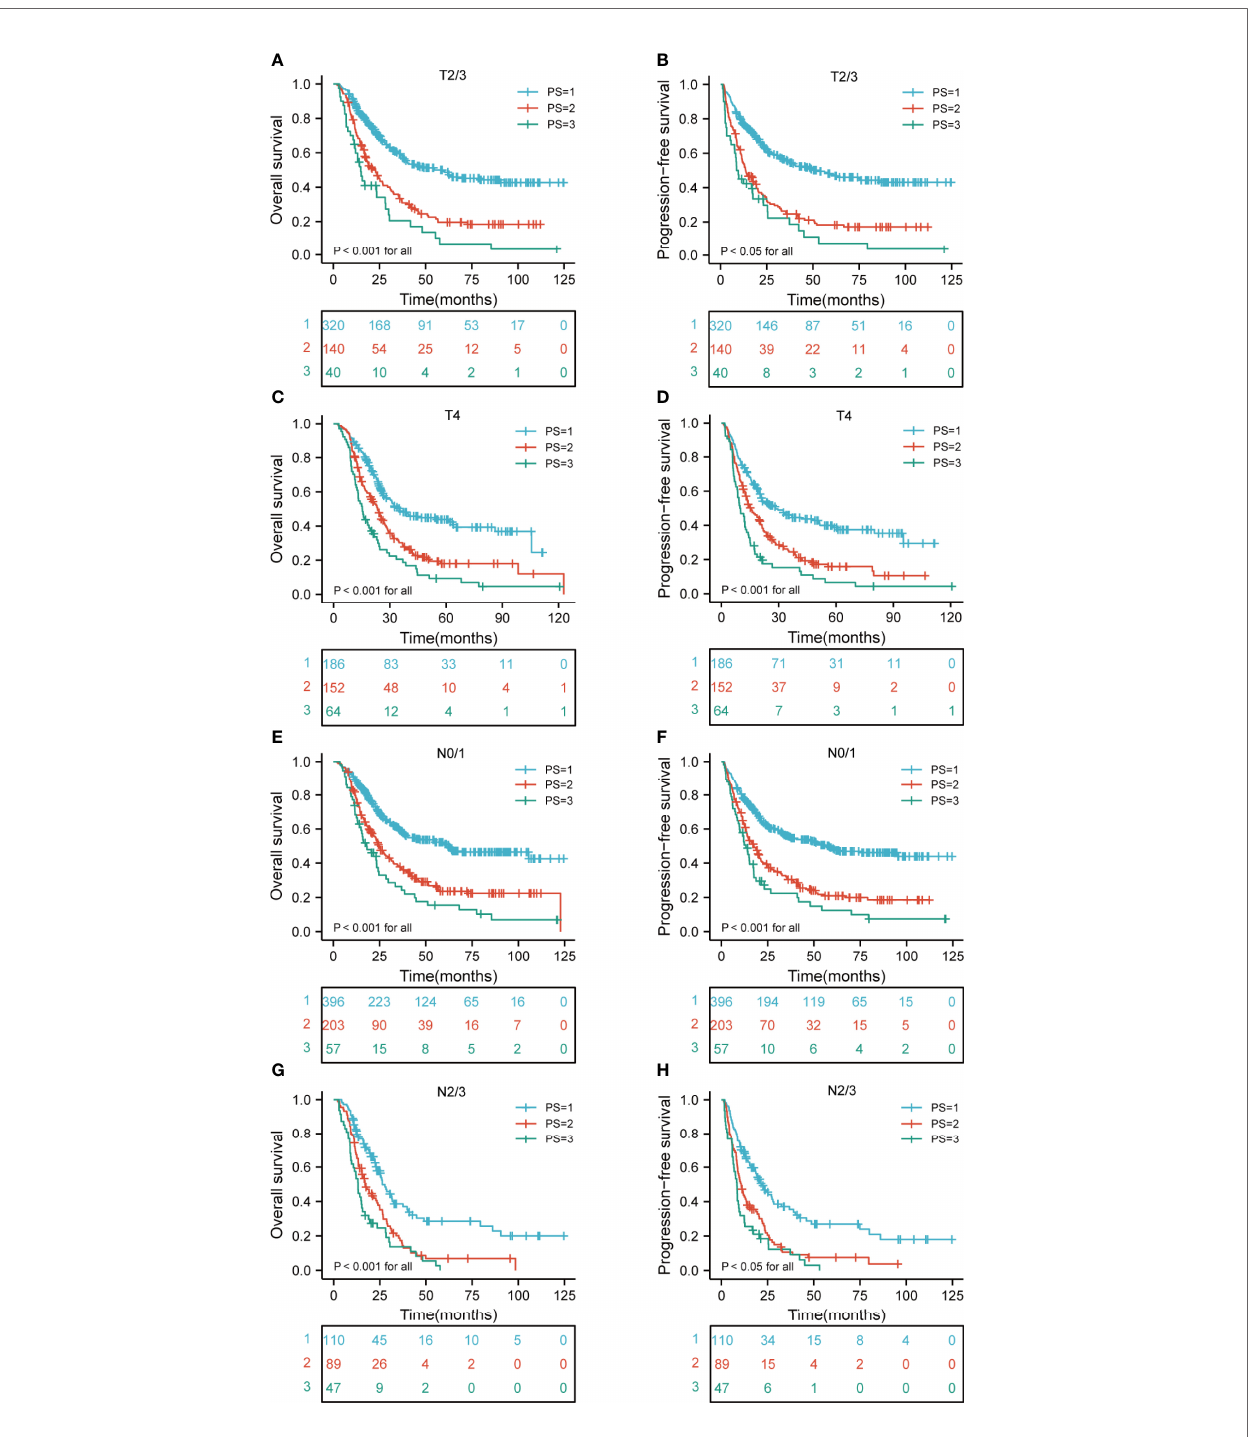
FIGURE 4 | Kaplan-Meier curves according to T and N stage categories for the whole study population according to risk groups showing (A – D) OS and PFS (p < 0.05 for all) of patients with T2-4; (E – H) OS and PFS (p < 0.001 for all) of patients with N0-3. T, tumor; N, node; OS, overall survival; PFS, progression-free